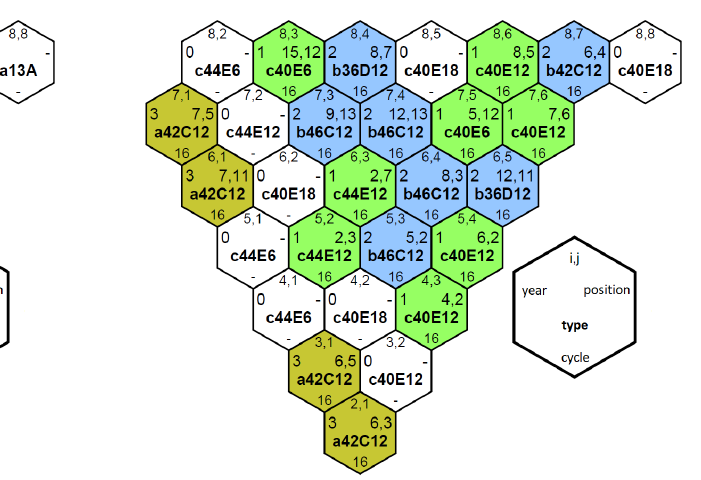
Figure 2. Mixed core u2c16. [5] Figure 3. Mixed core u2c17.